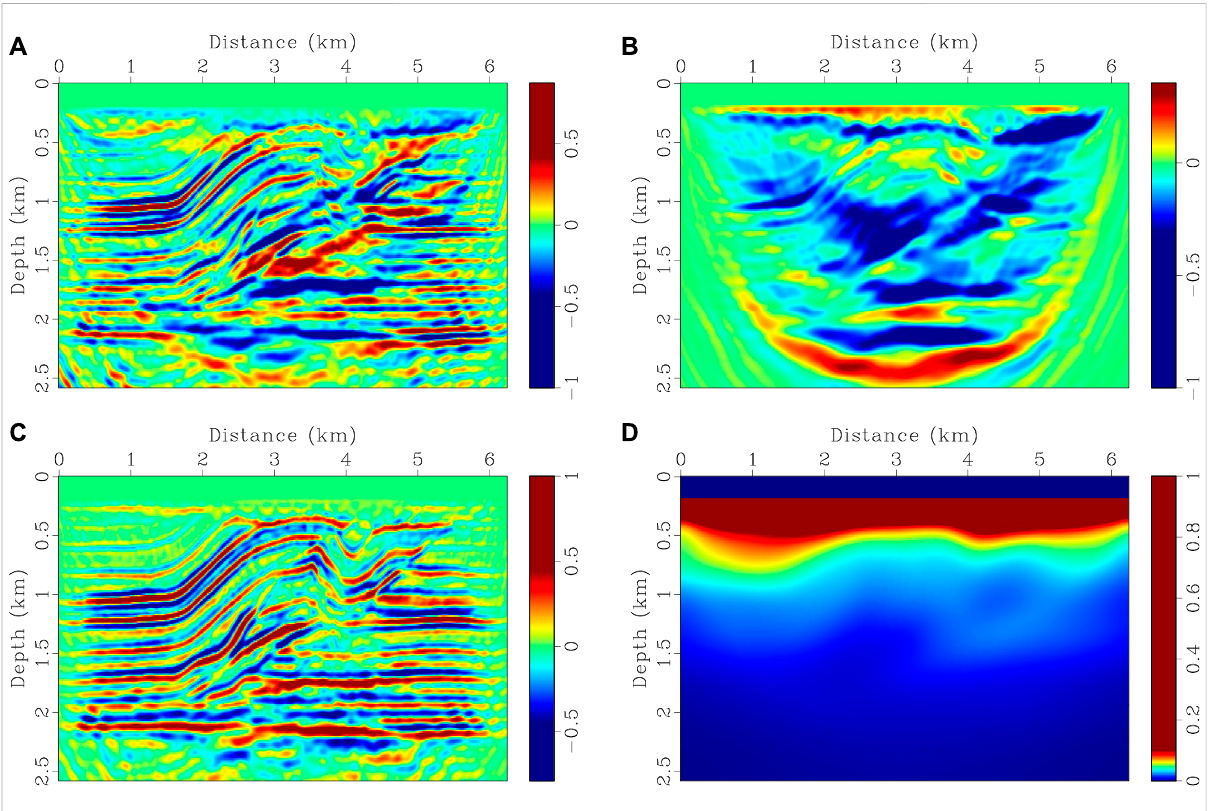
FIGURE 6 Comparison of different gradients in the fi rst iteration for SEG/EAGE overthrust model. (A) CSV-based gradient, (B) velocity and (C) impedance gradients,and (D) phase-encodingdiagonalGauss-NewtonHessian. (D) IsusedasapreconditionerinbothCSV-basedandHG-basedFWImethods. The magnitude of each panel is normalized with respect to their maximum